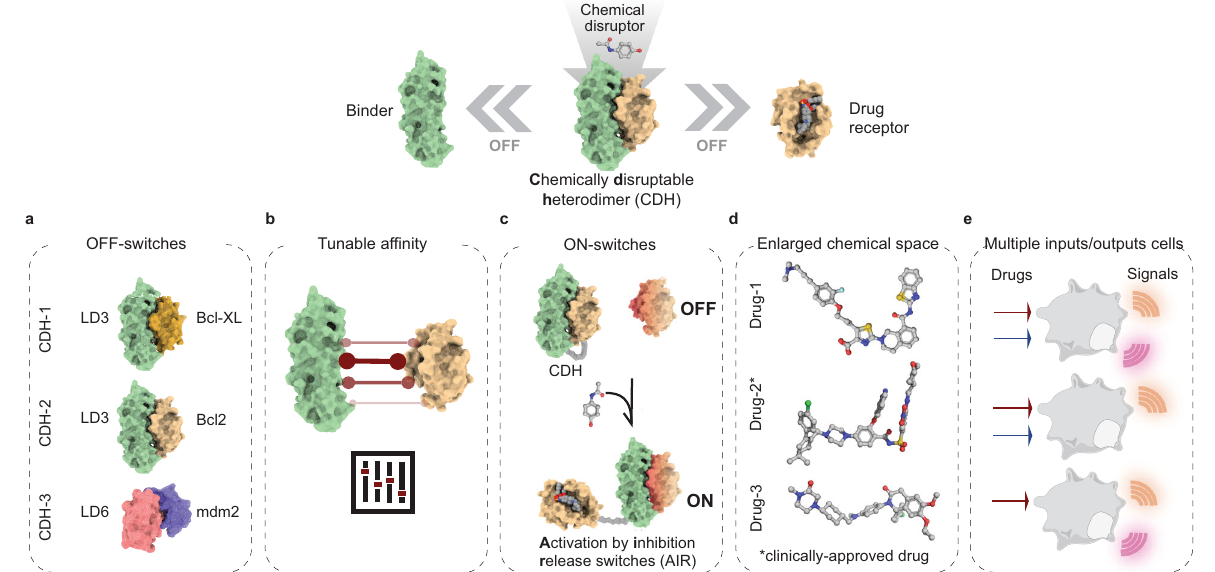
Fig. 1 Overview of structure-based design strategies employed to create novel small-molecule responsive switches. These design strategies include: (I) binding site transplantation to create new CDHs ( a ) that can be used to control cellular activities; (II) Interface mutations for af fi nity tuning ( b ) to alter drug concentrations that interfere with assembly of the complexes; (III) Multistate design to create drug insensitive receptors that are embedded in multi- domain architectures that dimerize upon drug exposure ( c ). This protein switch toolbox enlarges the chemical space ( d ) and can be used for the engineering of cells which sense several chemical cues and output a variety of signals ( e